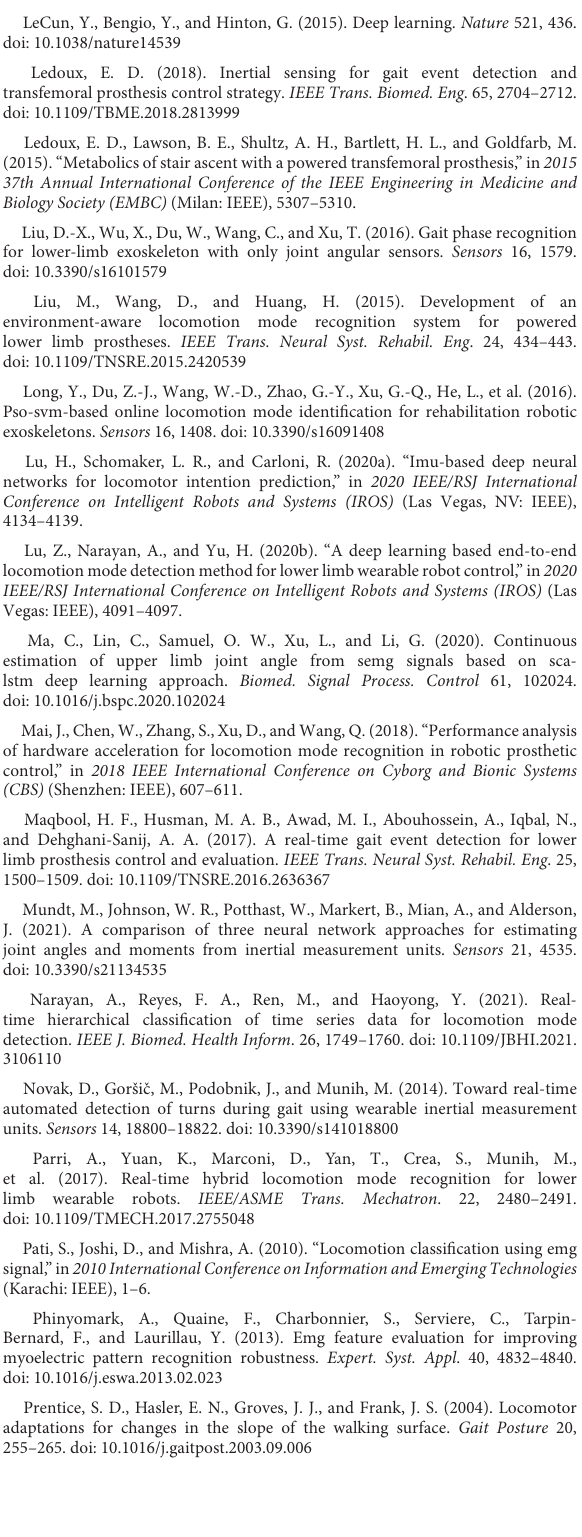
Taborri, J., Palermo, E., Rossi, S., and Cappa, P. (2016). Gait partitioning methods: a systematic review. Sensors 16, 66. doi: